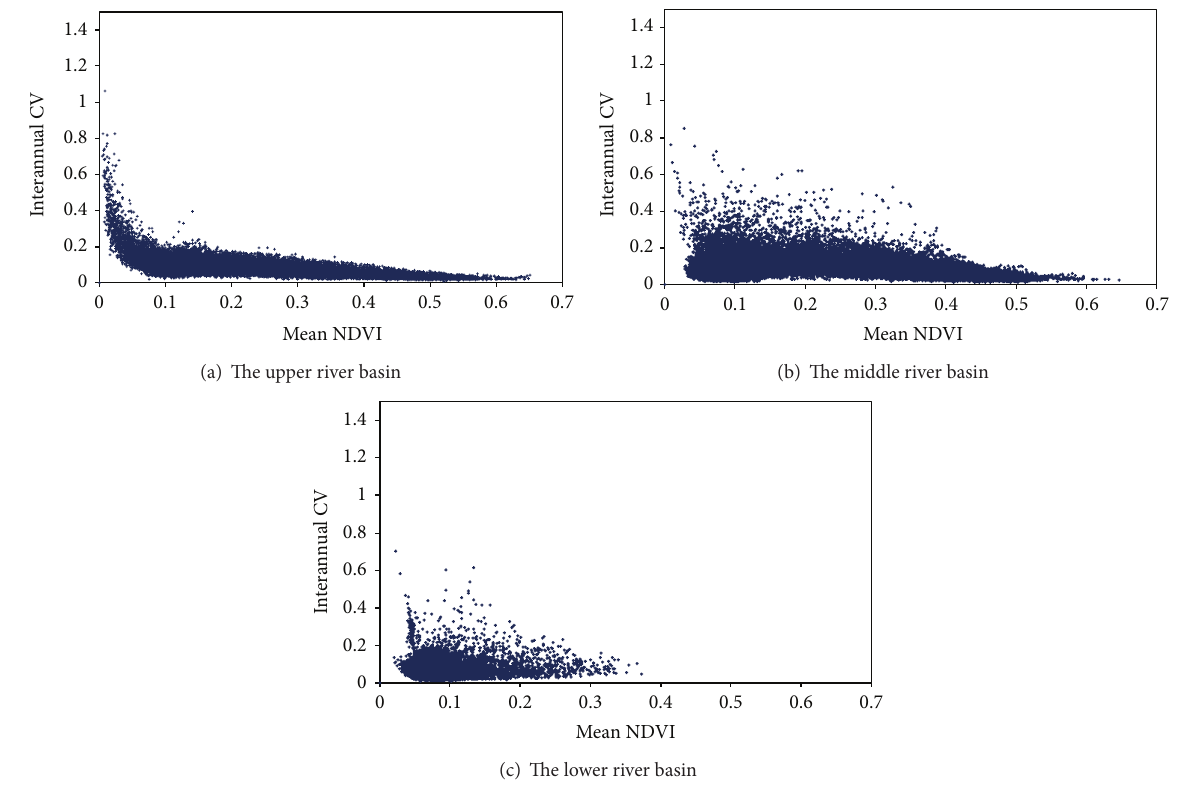
Figure 7: Relations between interannual CV and mean NDVI.